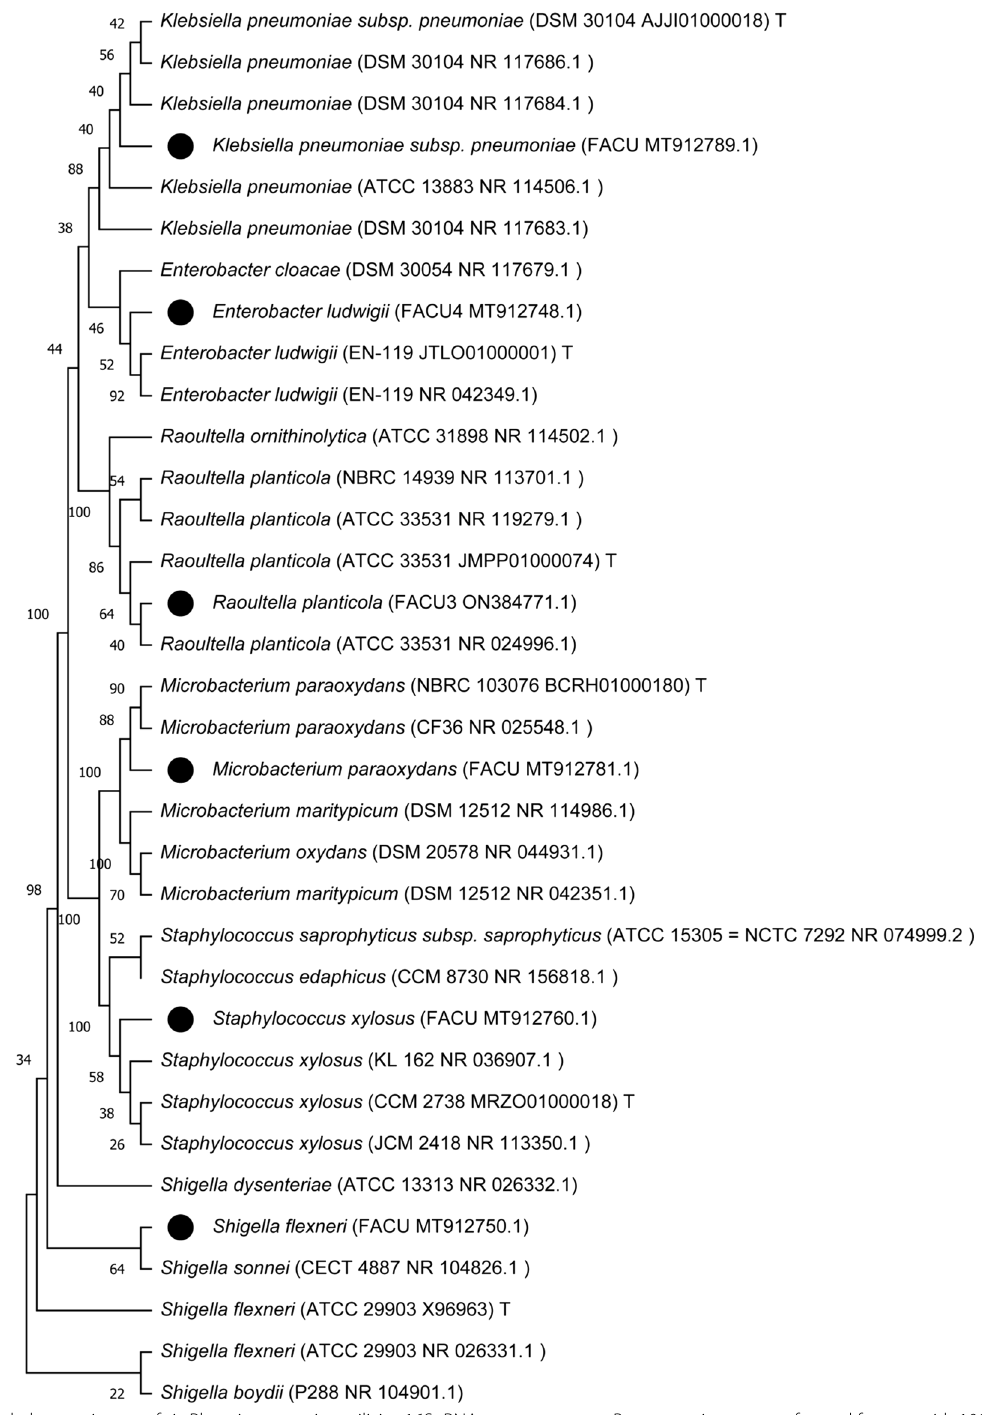
Fig. 1 The phylogenetic tree of six Pb resistant strains utilizing16S rRNA gene sequence. Bootstrapping was performed for tree with 1000 replicates. Phylogenetic analyses were conducted in MEGA